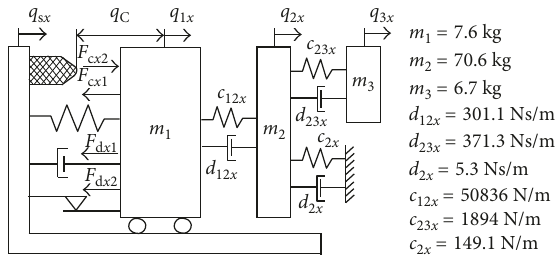
Figure 4: Physical model of the passive horizontal seat suspension with seated human